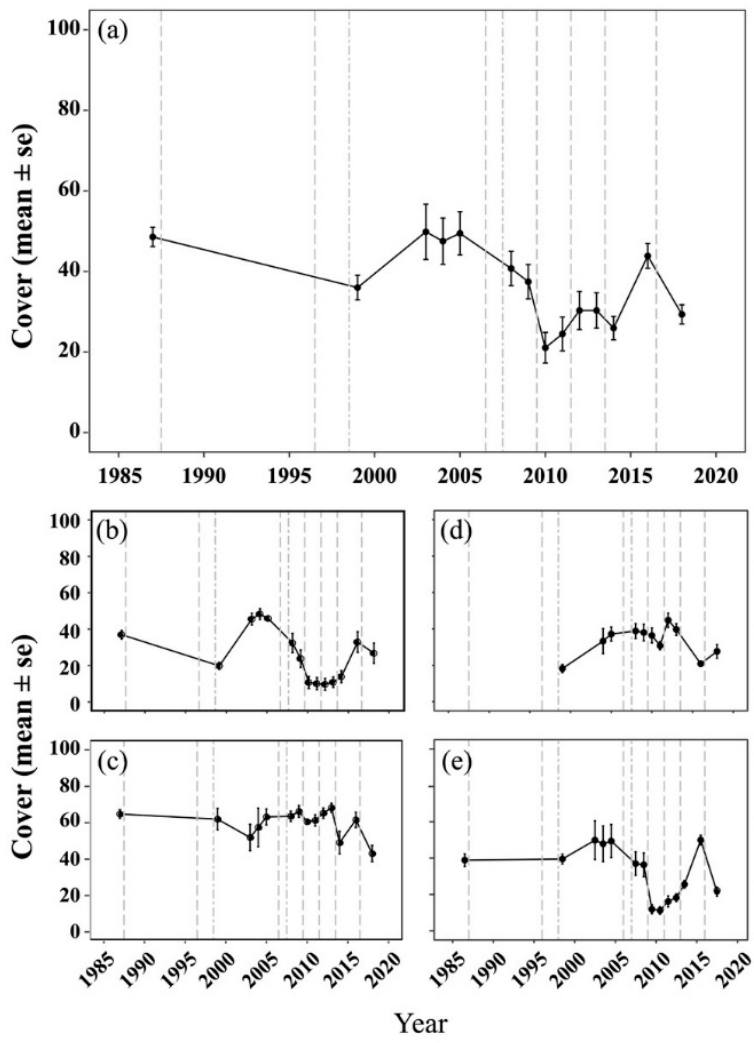
Figure 5. Spatial and temporal long-term trend of average living total coral cover (LCC, per transect ± standard error) in KNP from 1985 to the present. ( a ) the average LCC in the Kenting National Park scale, ( b ) the west, and ( d ) the east coast of Hengchun Peninsula; ( c ) the west, and ( e ) the east coast of Nanwan. The wide and narrow dashed lines indicate typhoons and bleaching events in KNP. The data were collected from the dataset listed in Table 1. The detailed survey methods of the data used in this figure are listed in Table 1. In order to compare the LCC at similar depth, only the transects laid out between 5 and 10m in depth at each site from 1986 to 1999 (Dai, C.-F. 1988; Dai, C.-F. etc. 1998, 1999) were used to generate the figure, combined with the data collected after 2003, including data from a PhD thesis (Dai, C.-F. 1988), one article published in the proceeding of the 6th International Coral Reef Symposium Dai, C.-F. (1988) and two local journal articles written in Mandarin with English abstract (Dai, C.-F. etc. 1998, 1999). The data of LCC after 2003 were collected by the co-first author C.-Y.K. and the corresponding author C.A.C. Di ff erent parts of this dataset have been published as a Master’s thesis (Kuo, C.-Y. 2007), in local project reports (Kuo, C.-Y. etc. 2012; Shao, K.-T. etc. 2002; Fang,